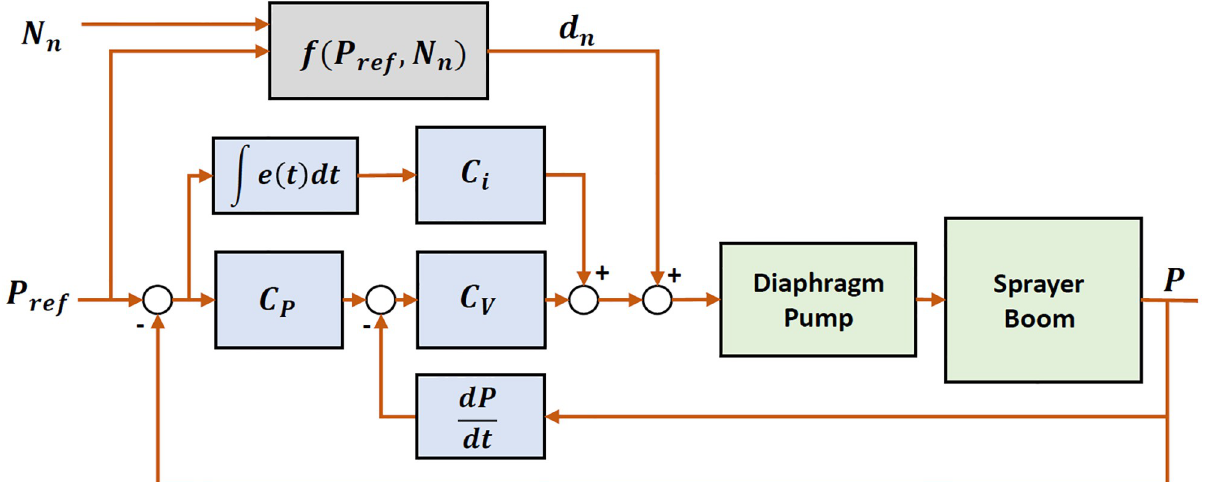
Fig 6. Block diagram of cascaded controller for pressure control